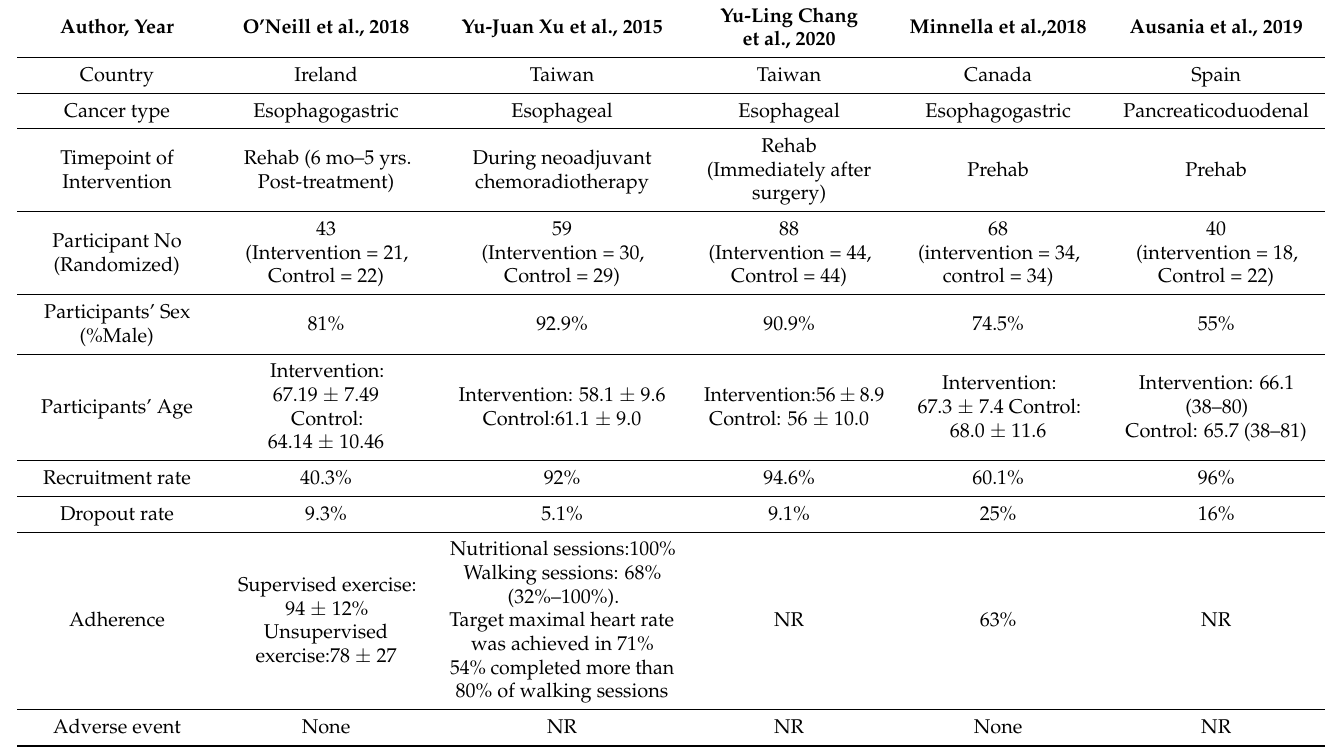
Table 1. Overview of the included